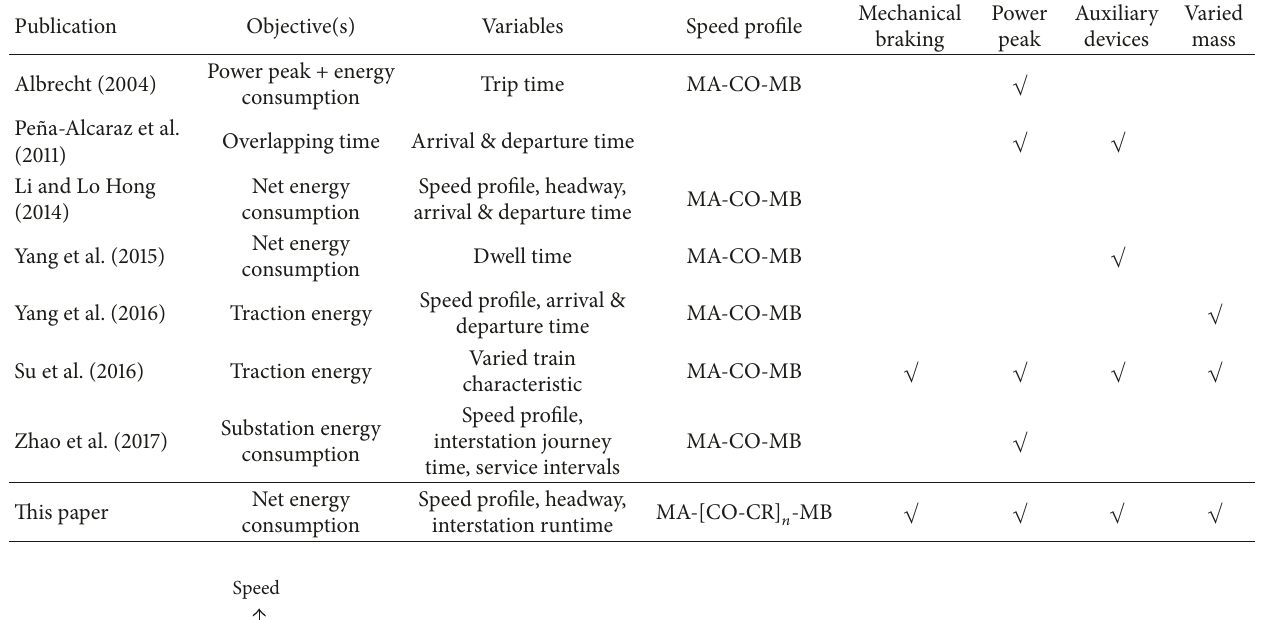
Table 1: Literature on energy-efficient timetabling with RBE.